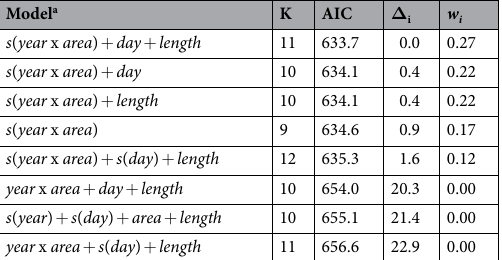
Table 1. Information criteria for comparison of candidate models for Townsend’s big-eared bats from hibernacula surveys from winter 1984–1985 to winter 2015–2016 in southern Idaho, USA; K = number of parameters, AIC = Akaike’s information criterion, Δ i = delta AIC, w i = Akaike weight. a Fixed effects: year , the year the cave was surveyed; area , the management area in which the cave was located; day , the sequential day of winter during which the cave was surveyed; and length , cave length (m). Variables with s () notation are smoothed, otherwise all other variables are linear. Interaction terms indicated by x (e.g., year x area ) and imply inclusion of main effects. A random effect of cave (a site identifier) is not shown, but was included in all